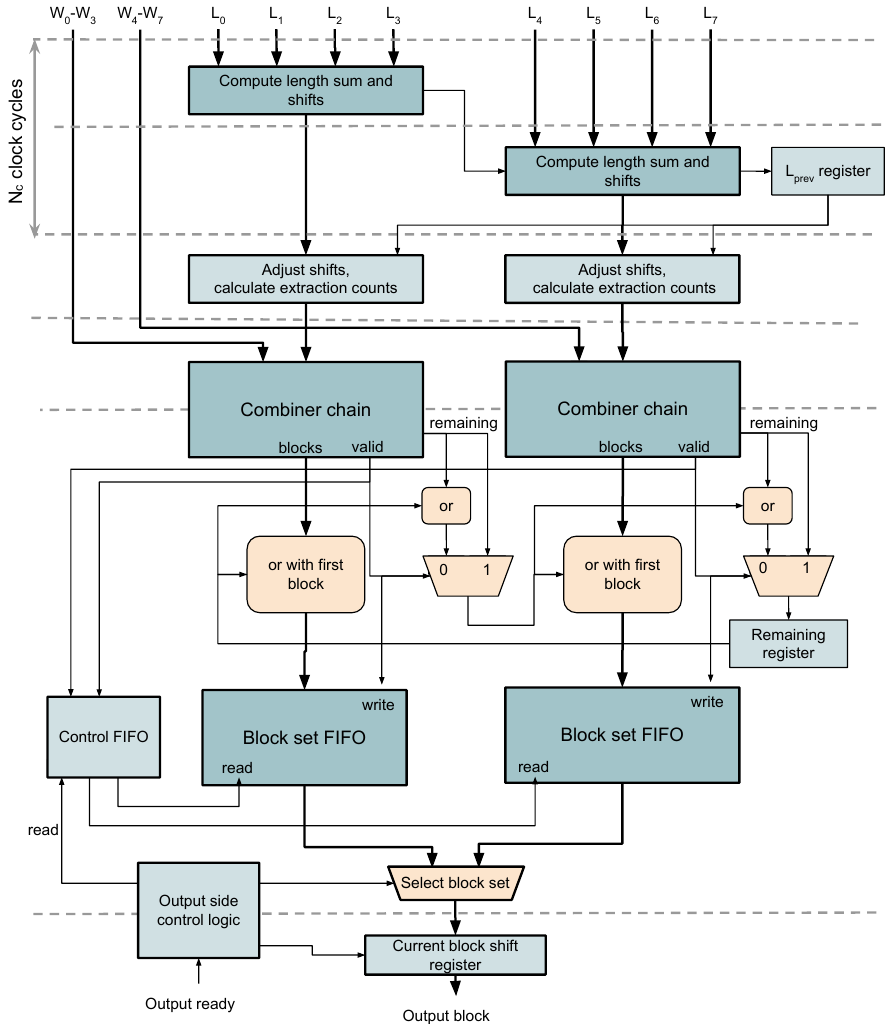
Figure 12. Implementation of improved variable length word packer.